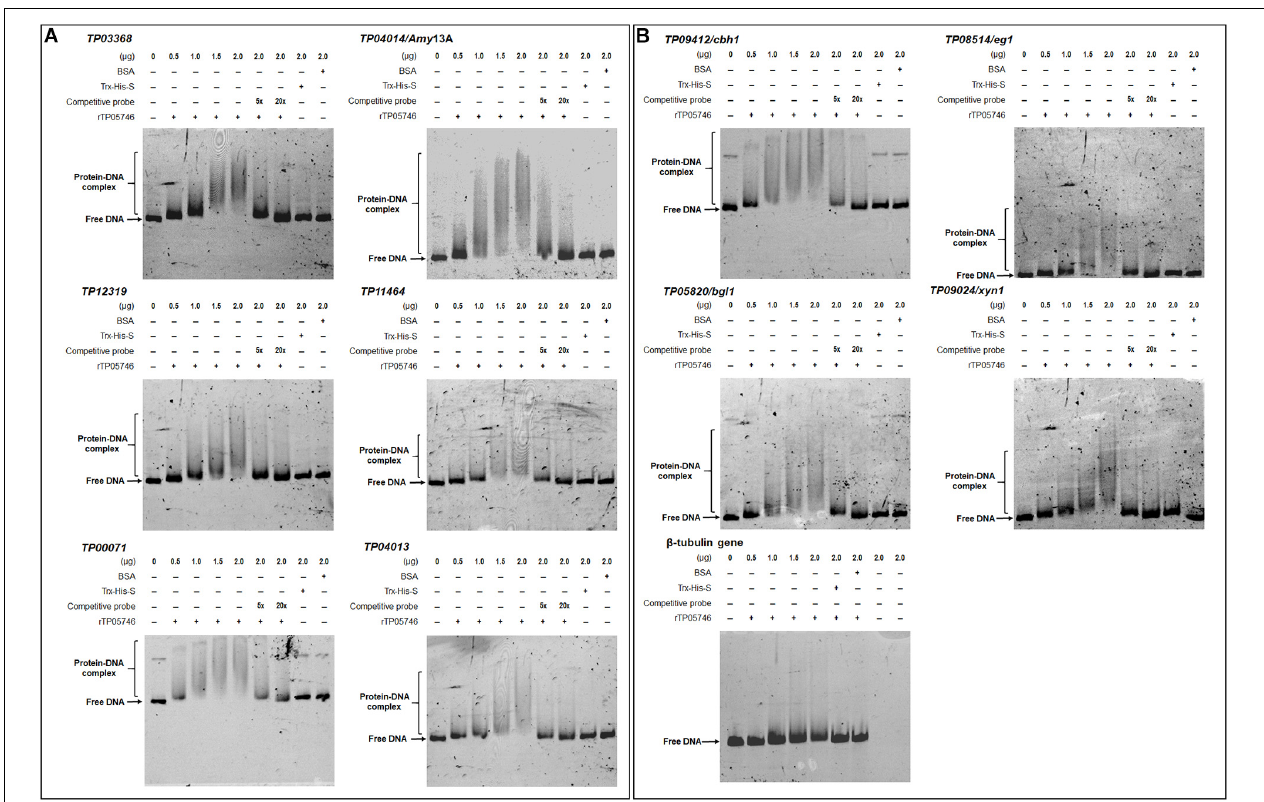
FIGURE 8 | Interaction between TP05746 and genes encoding enzymes as revealed by electrophoretic mobility shift assay (EMSA). (A) Amylase genes. (B) Cellulase and xylanase genes. The recombinant protein rTP05746 (0–2.0 µ g) was mixed with approximately 50 ng of FAM-labeled EMSA probes. EMSA probes lacking the FAM label were used for competitive EMSA. BSA, Trx-His-S fusion protein or the promoter region of the β -tubulin gene alone were used as controls. FAM, 6-carboxyfluorescein; EMSA, electrophoretic mobility shift assay; BSA, bovine serum albumin. In each EMSA reaction, non-specific sheared salmon sperm DNA was added, in order to prevent non-specific binding between protein and